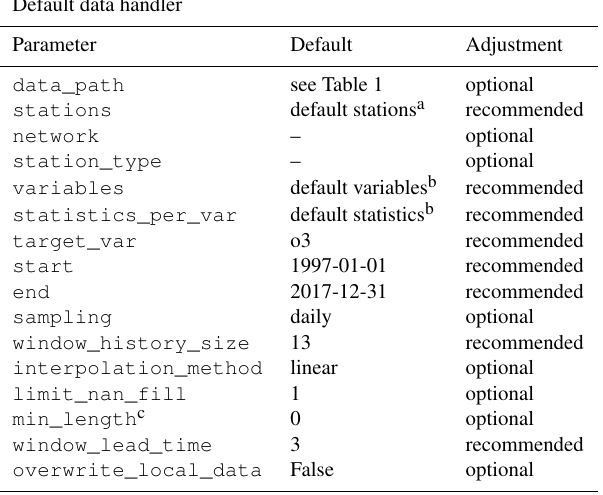
Table 3. Summary of all parameters related to the default data han- dler that are required, recommended, or optional to adjust for a cus- tom experiment